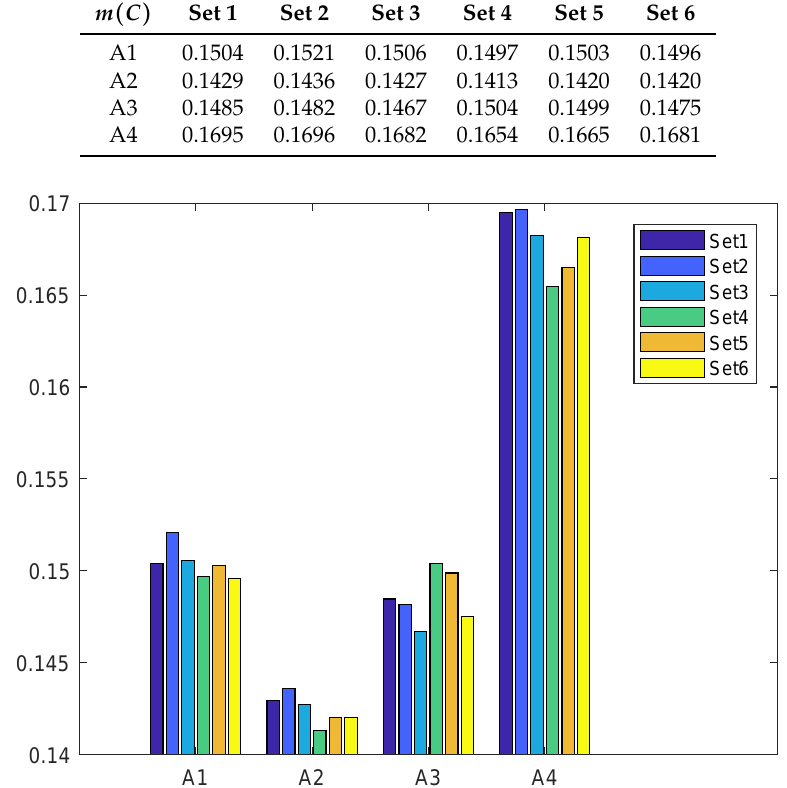
Figure 2. Sensitivity analysis of the subjective weights of the criteria.